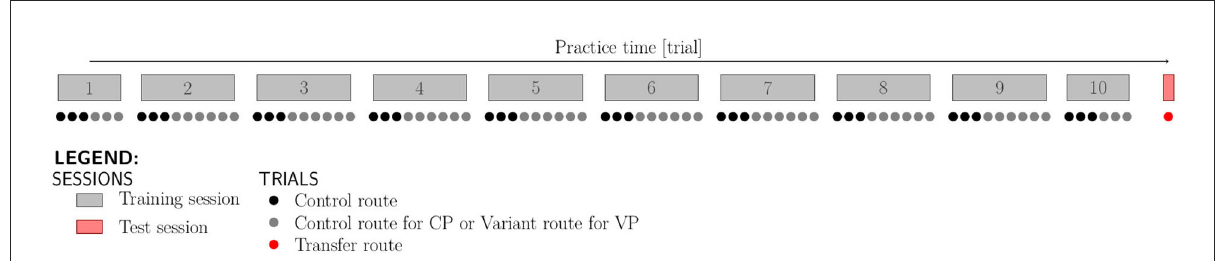
FIGURE1 Protocol of data collection for the acquisition of a behavioral signal. The rectangular blocks in the top figure count the sessions. The dots in the bottom figure illustrate the number of trials in the sessions, which was the same for all the groups (CP, VP1, and VP2). The color of the dots distinguishes the variability that was introduced. The black dots represent the route that was identical for all the climbers in all the sessions and which was the control route. The gray dots represent either 1) control route in the case of the CP group, or 2) variant route in the case of the VP1 and VP2 groups. The last red dot symbolizes the transfer route (test route which was different from the control route or variant routes), which is used to assess participants’ progress when faced with a novel